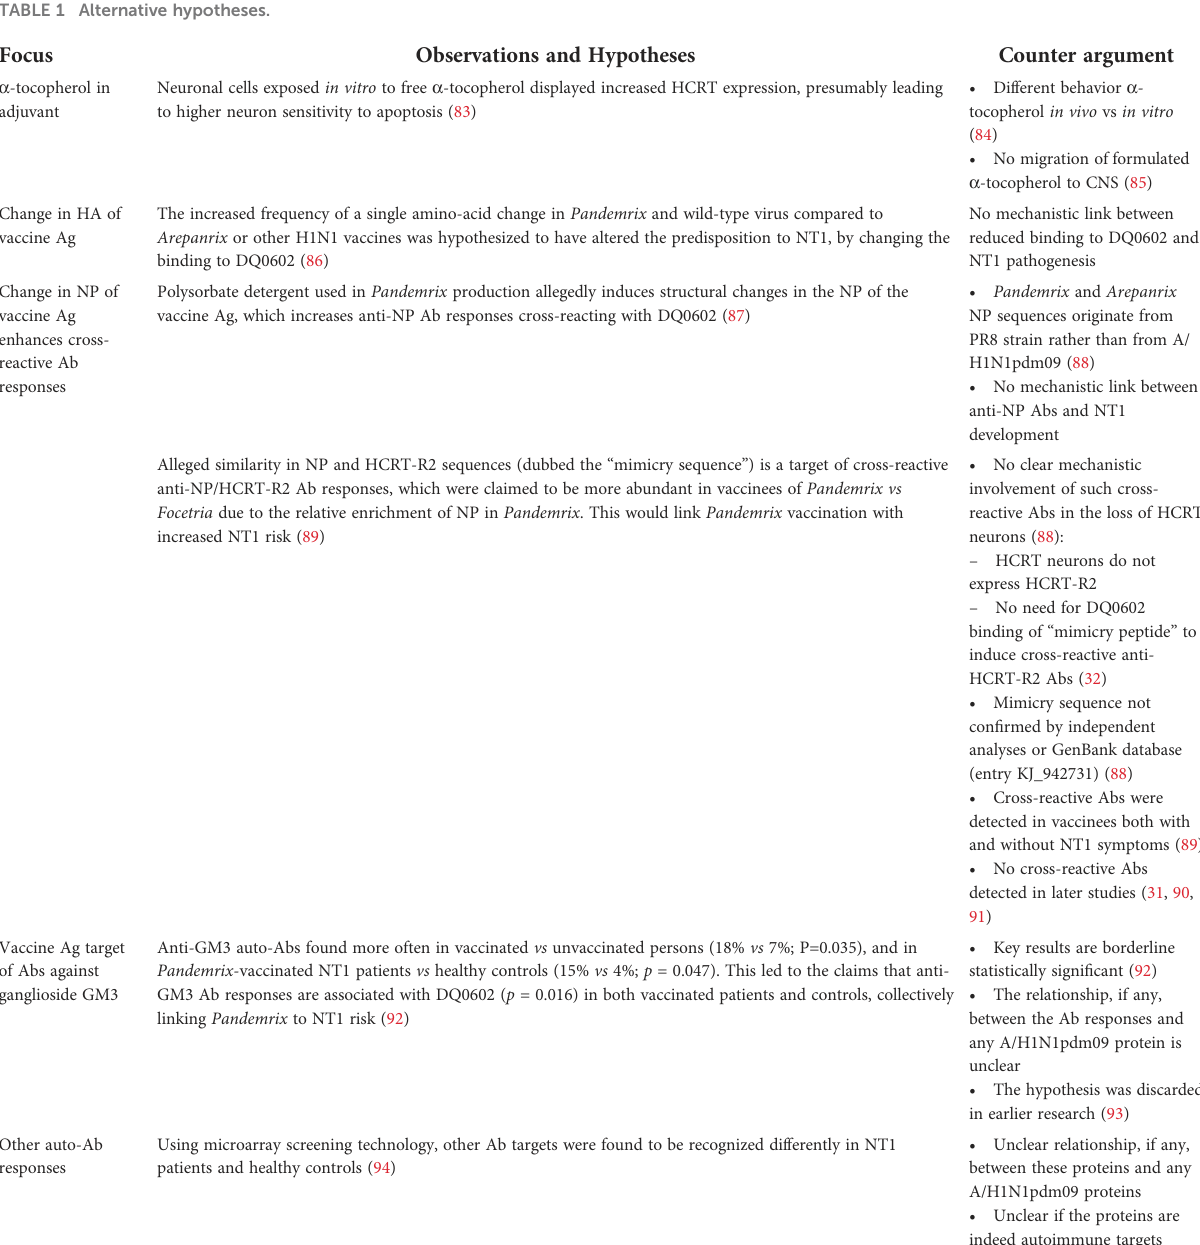
TABLE 1 Alternative